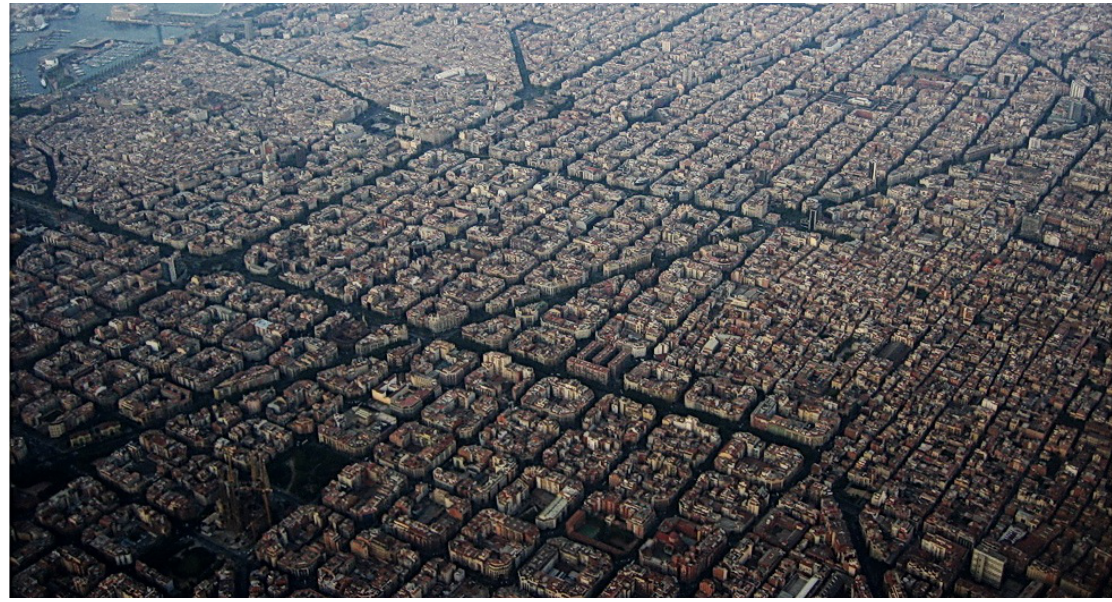
Figure 1. Aerial view of the urban grid structure of the city of Barcelona